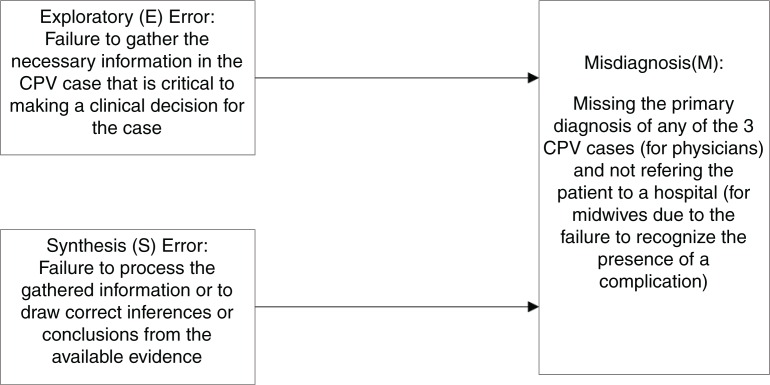
Framework for conceptualizing misdiagnosis.